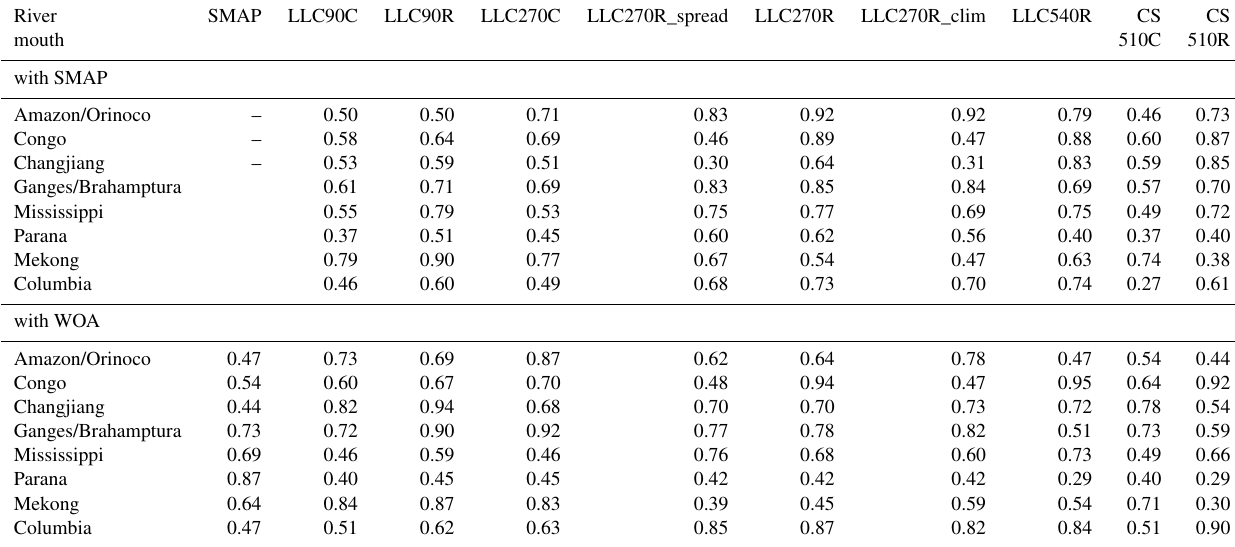
Table 3. The Willmott skill score for each run as compared with WOA18 and SMAP. The river mouth was recognized by the first EOF of WOA18 (see Figs. 5 and S1). Note that WOA18 data are a 30-year climatology (1981–2010) and not in the same period as SMAP and